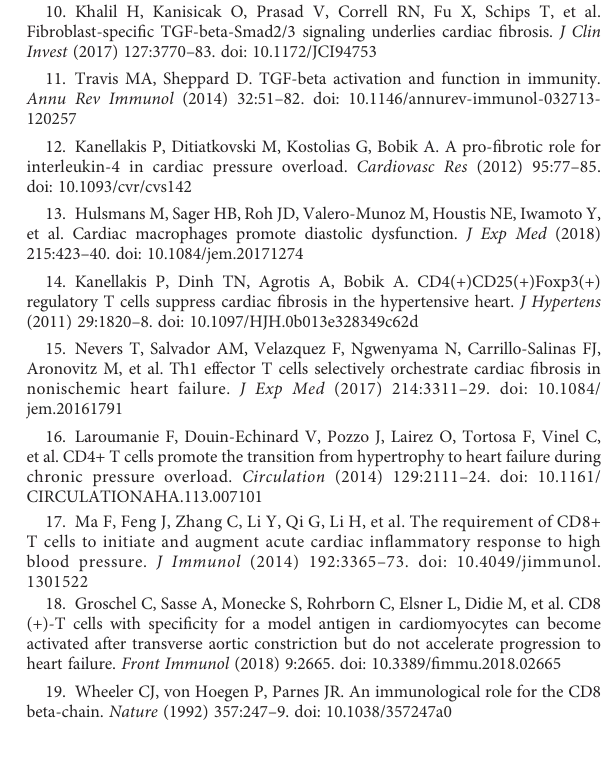
group. Results are means ± SEM with small circles representing data from individual mice. scale bar represents 50µm. *P < 0.05 using two-tailed Student ’ s t-test, comparing to either 2K1C+IgG or DOCA+IgG. SUPPLEMENTARY FIGURE 2 NK/NKTandTCR gd TcellsexpressNKG2DreceptorsinTACCD8T-NKG2D +/ + mice. Miceweresubjected to mixedchimericapproach(seetextfordetail) to generate mice with CD8+ T cell-speci fi c NKG2D de fi ciency (CD8T- NKG2D -/-) . Representative photomicrographs demonstrating the expression of NKG2D in NK1.1+ and TCR gd + cells accumulated in fi brotic areas of left ventricles in TAC CD8T-NKG2D -/- mice as well as TAC CD8T- NKG2D +/+ control mice. scale bar represents